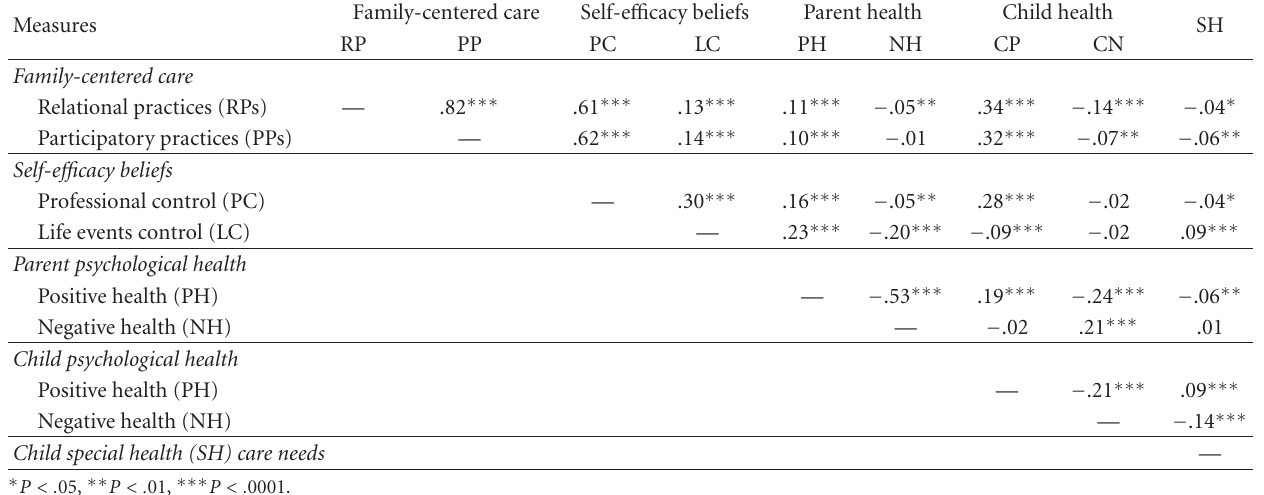
Table 1: Weighted pooled correlation matrix for the relationships between the study variables.